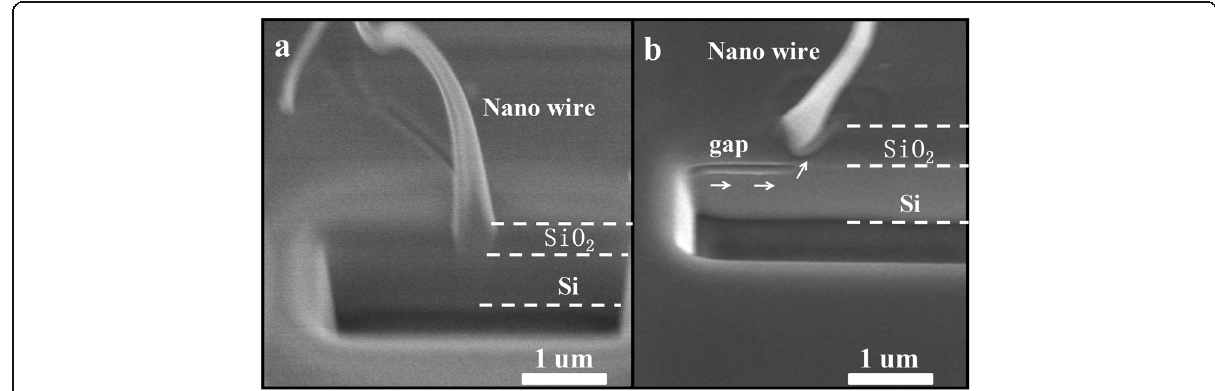
Fig. 5 SEM images of α -SiNW root. a , b The SEM images of α -SiNW root part at tilt 45° after FIB etching. A long Si gap is found at the Si /SiO 2 interface in ( b